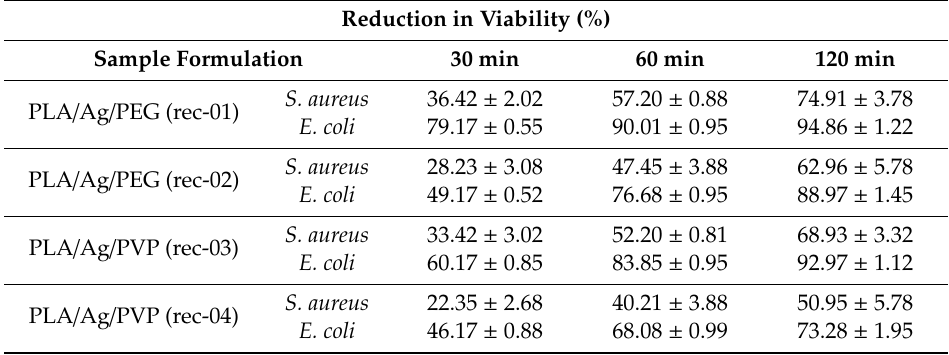
Table 1. Antibacterial activity of 3D printed PLA / AgNP nanocomposites (@100 µ m printed layer thickness) against S. aureus and E. coli after Di ff erent Incubation Times ( n = 3, p < 0.05).